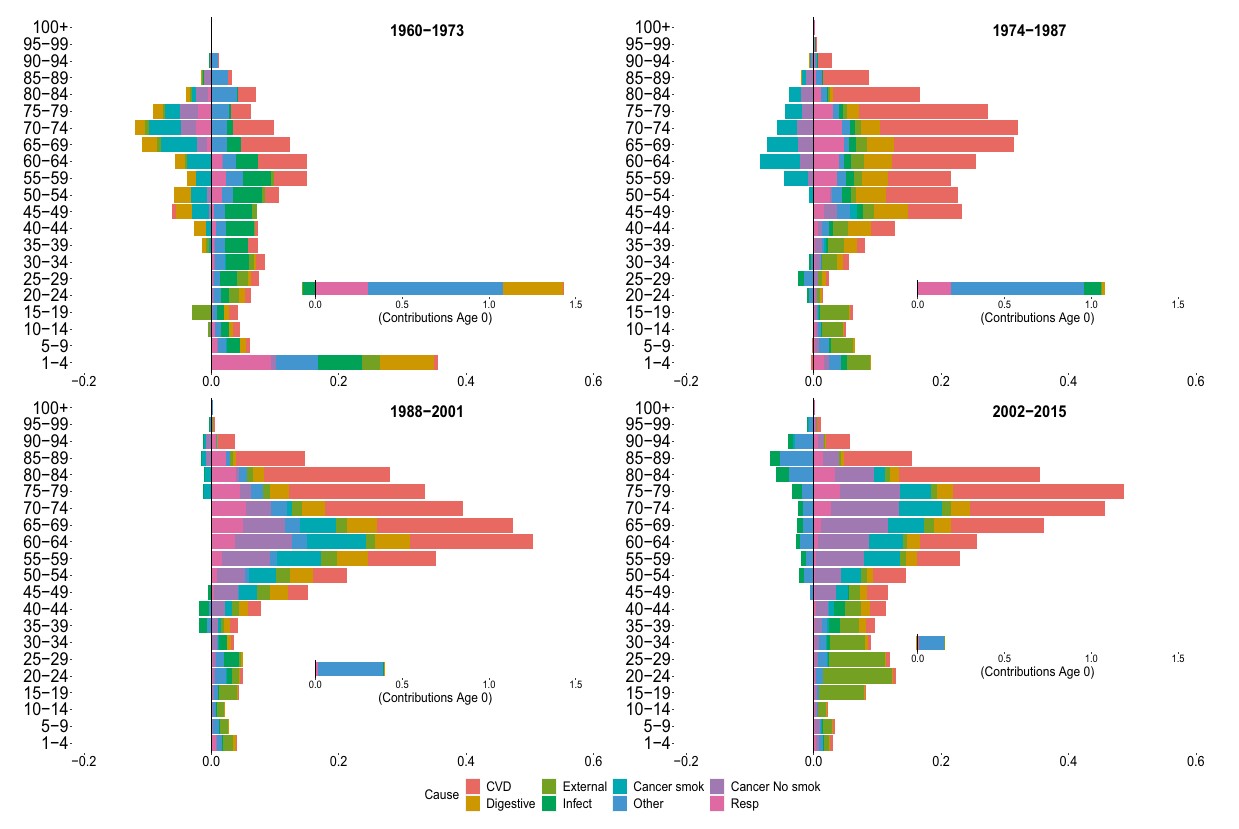
Figure 3. Age and cause contributions to changes in life expectancy for Italian